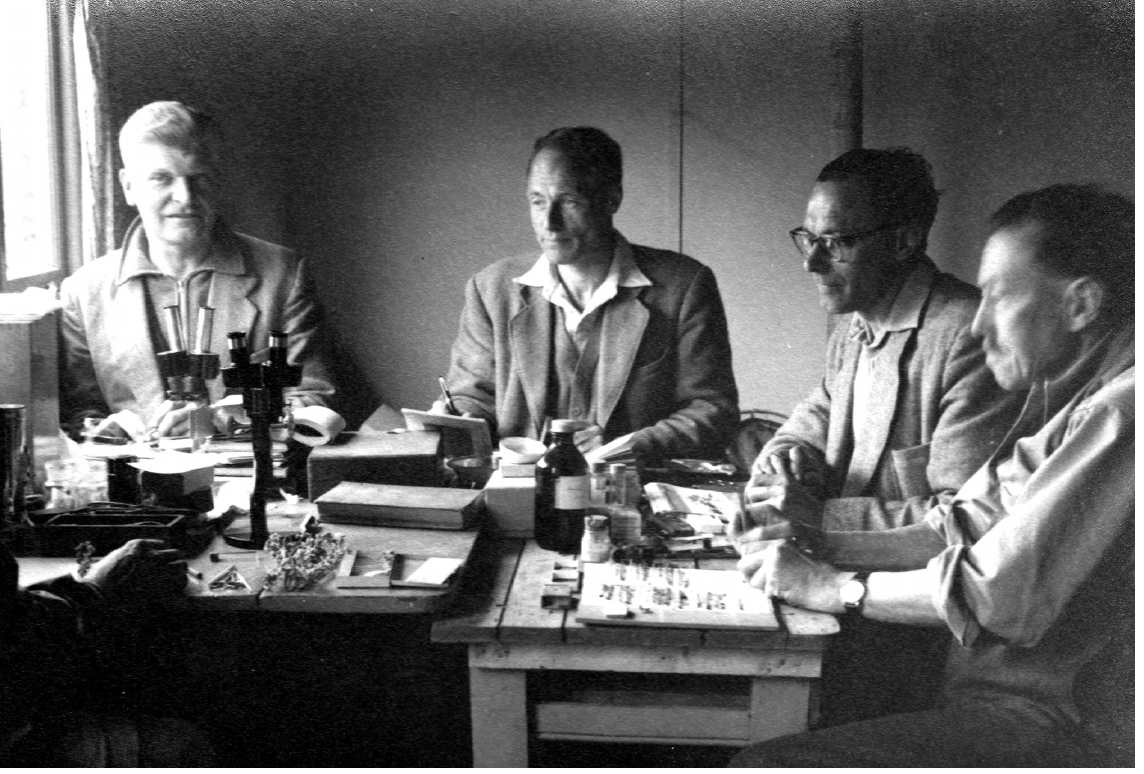
Fig. 9. Freshfield Insect Survey, June 1959. Left to right: W.D. Hincks, M.W.R. de Vere Graham, A. Brindle and C.H. Wallace Pugh (MMUE